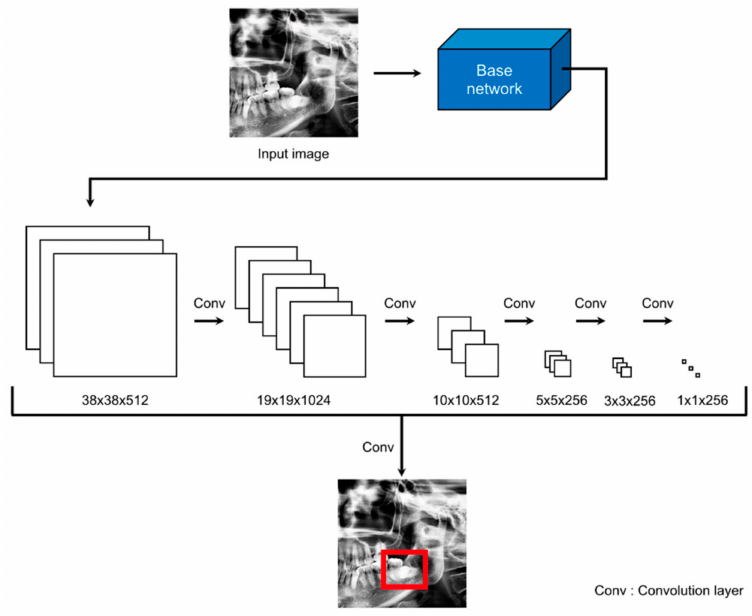
Figure 2. SSD300 architecture. The red box means ROI.